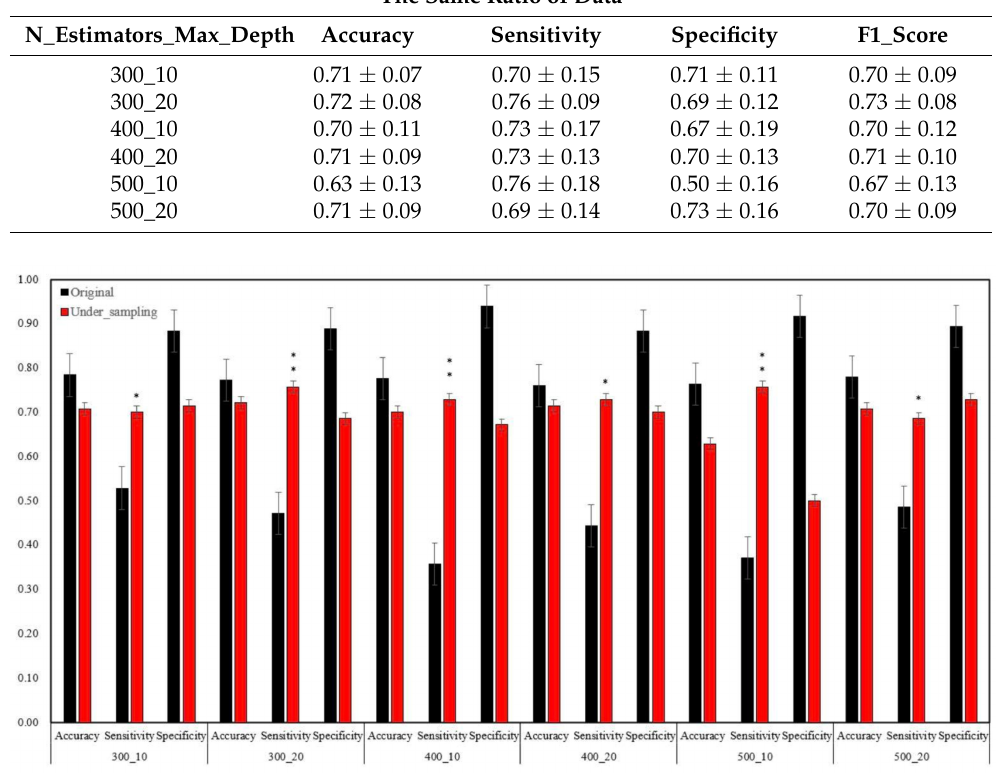
Figure 6. Different hyperparameters with random under-sampling strategy. * significant, ** highly